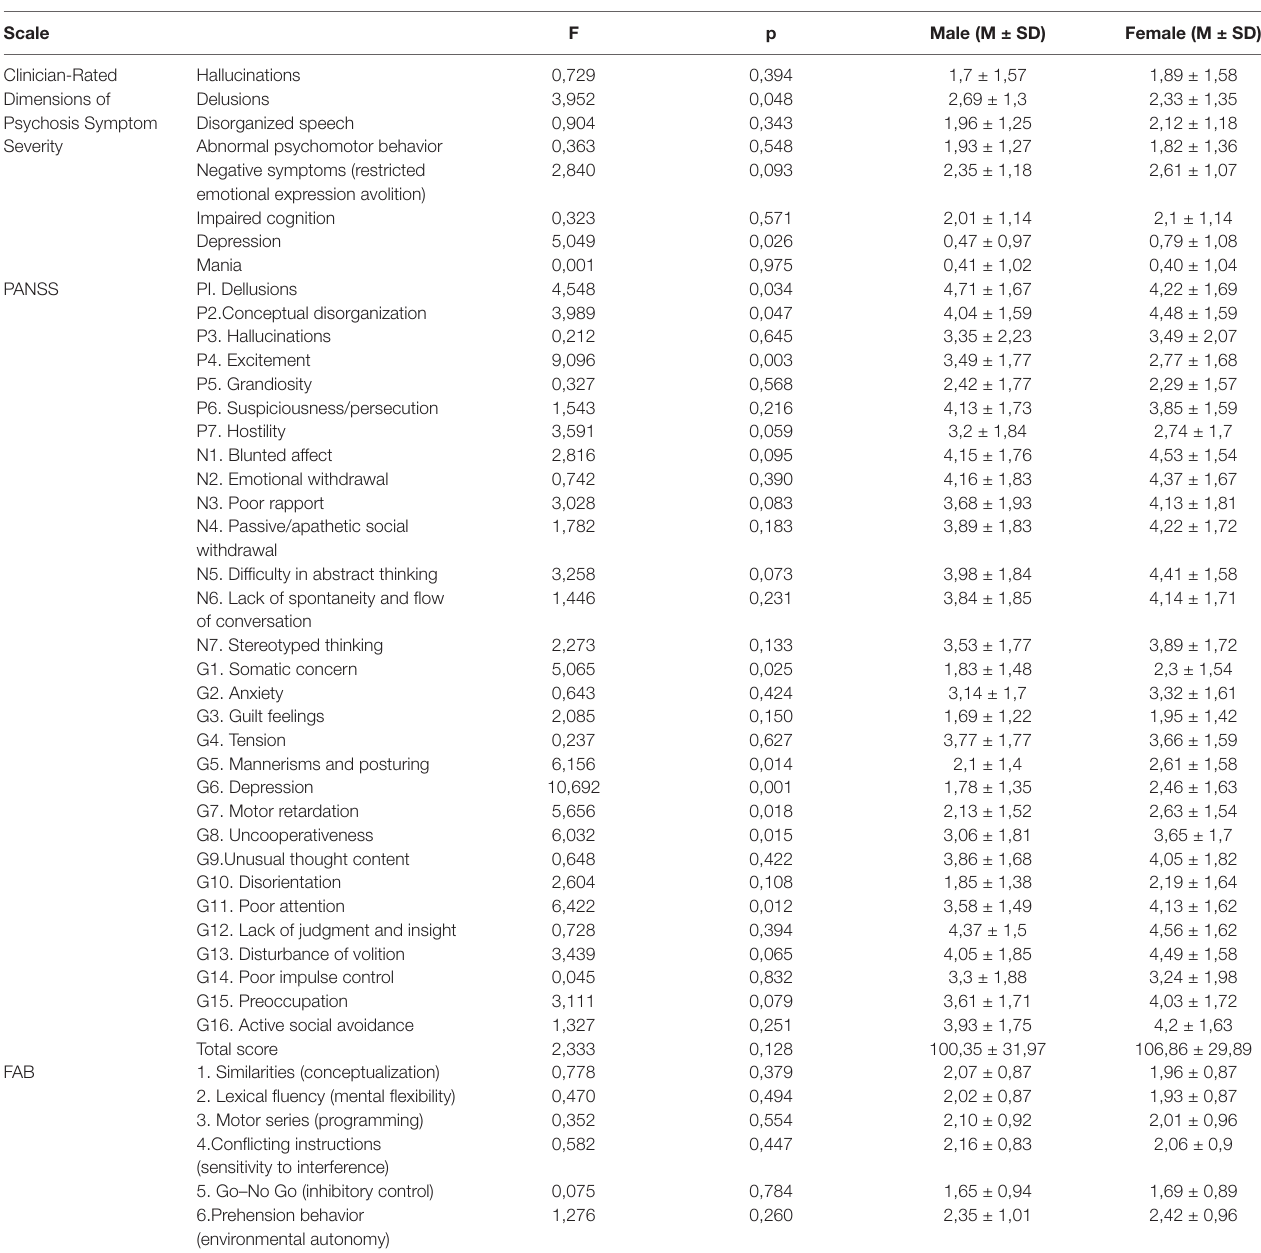
TABLe 3 | The gender differences of clinical characteristics of the patients. Scale F p Male (M ± SD) Female (M ±